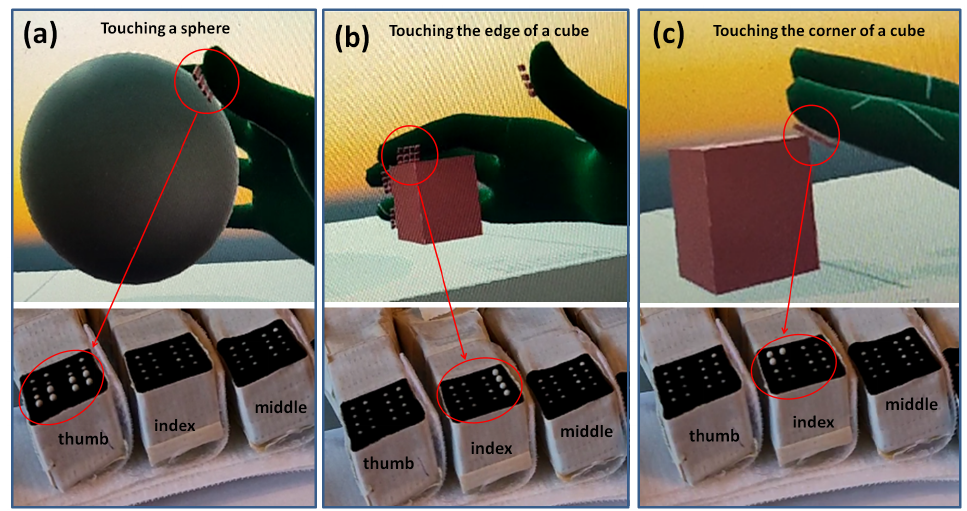
Figure 17. Touching 3D VR objects. ( a ) Touching the surface of a VR sphere, ( b ) touching the edge of a cube, and ( c ) touching the corner of a